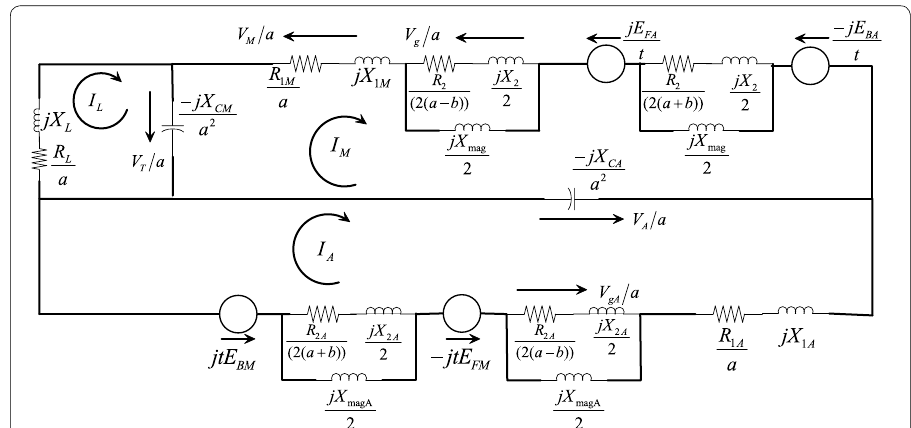
Fig. 2 The steady-state equivalent circuits of the proposed connection for